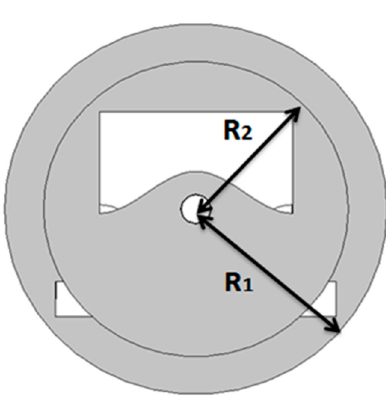
Figure 8. Cross-sectional view of CV-FWG and FWG.